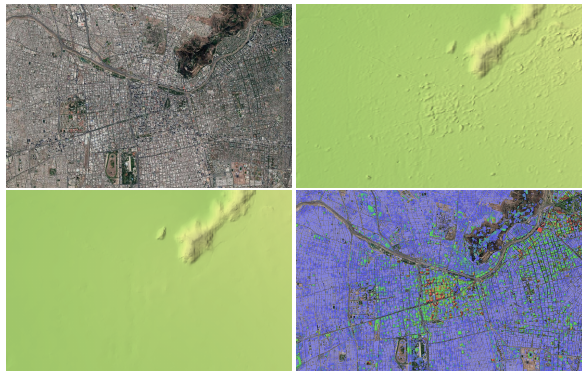
Figure 8. Example of the DTM estimation: AW3D30 DSM (top right), DTM (bottom left) and DHM (bottom